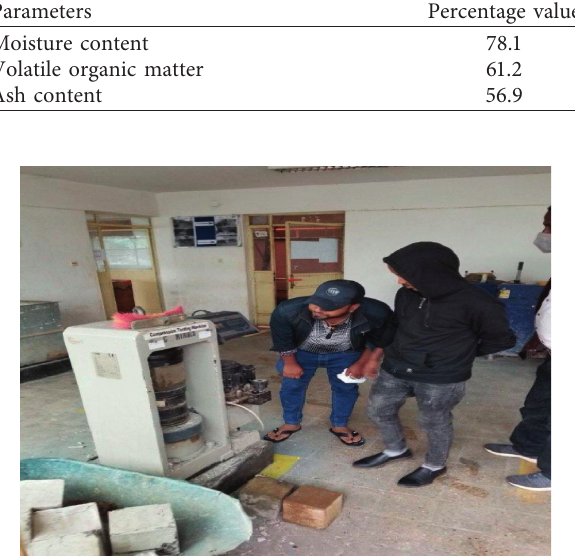
Figure 2: Compressive strength